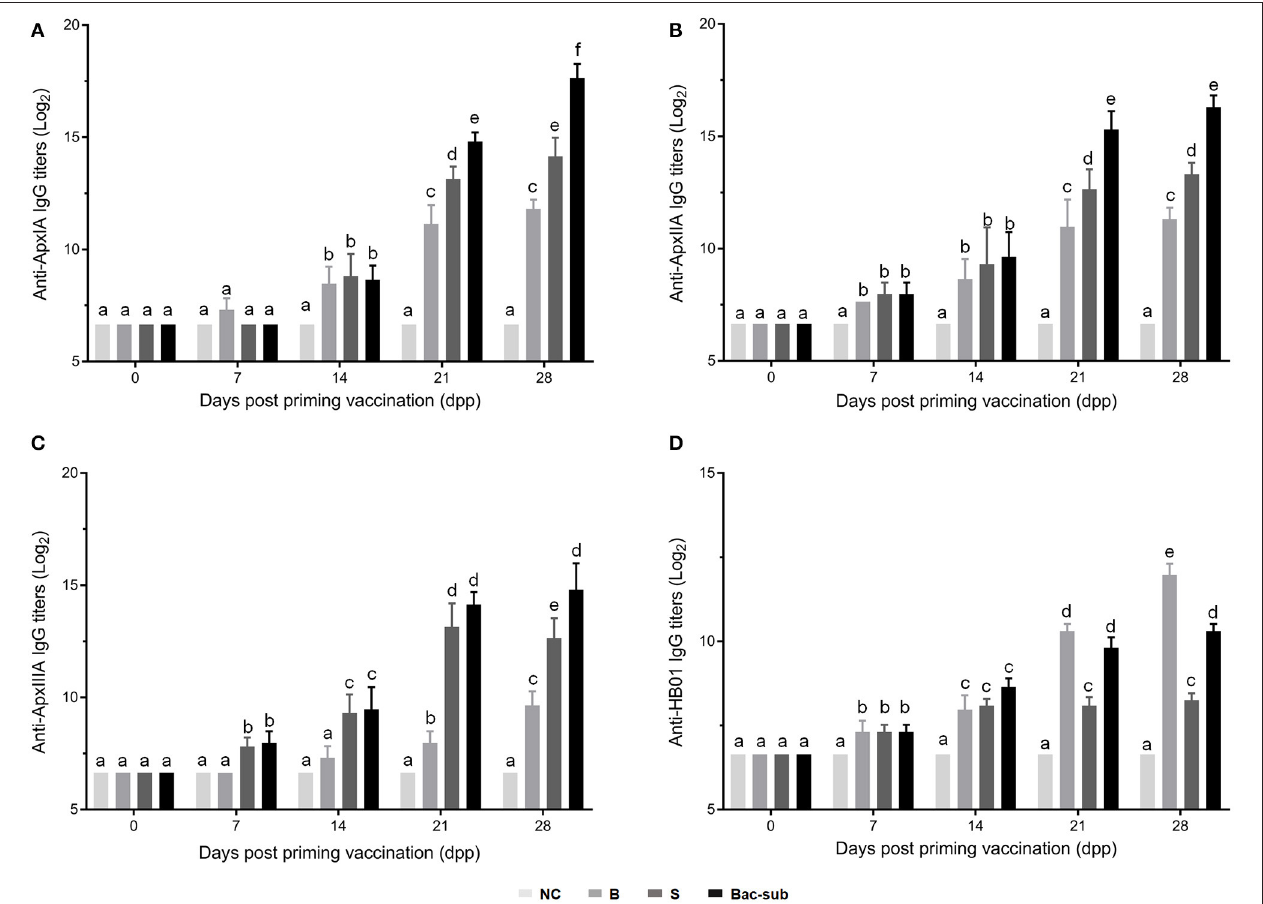
FIGURE 2 | IgG endpoint titers against ApxIA (A) , ApxIIA (B) , ApxIIIA (C) , and HB01 somatic antigens (D) in sera of mice vaccinated with the Bac-sub vaccine, subunit (S), bacterin (B), and phosphate-buffered saline (PBS) [negative control (NC)], respectively. When the letters at the top of columns are different, it means that the specific antibody titers are significantly different ( p < 0.05), otherwise the difference is not significant ( p >